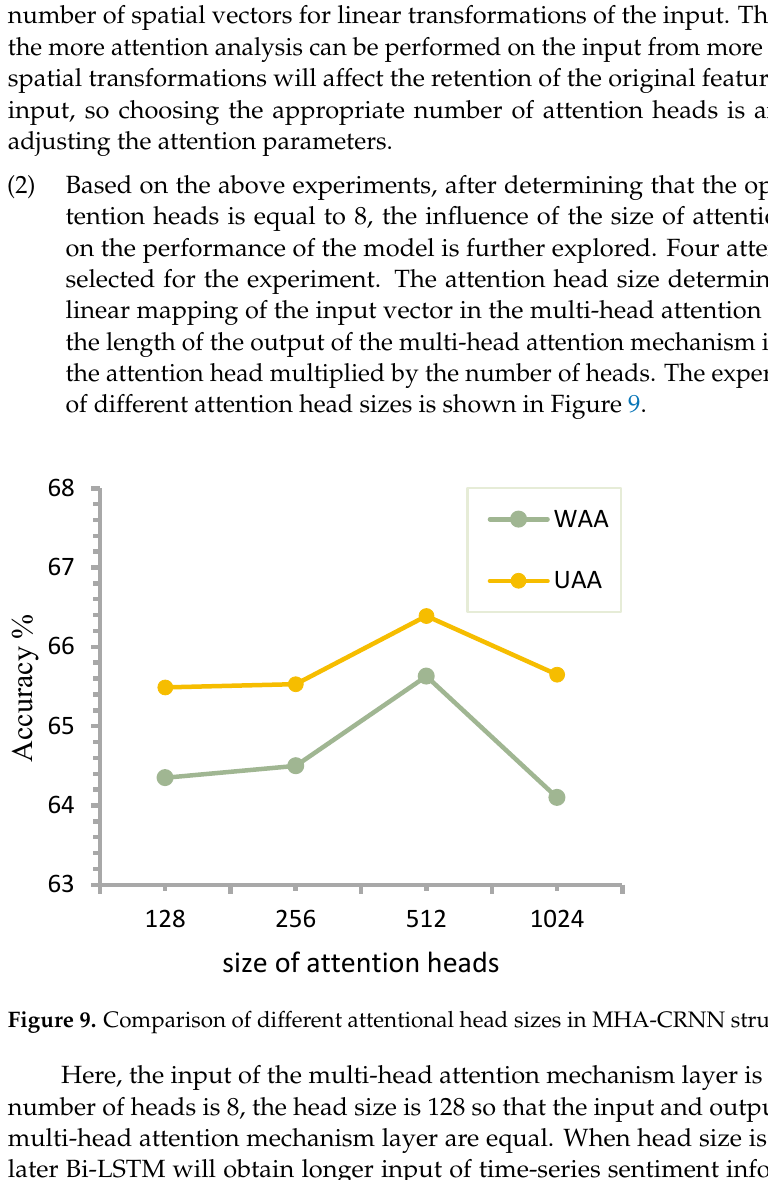
Here, the input of the multi-head attention mechanism layer is [19,1024], When the number of heads is 8, the head size is 128 so that the input and output dimensions of the multi-head attention mechanism layer are equal. When head size is larger than 128, the later Bi-LSTM will obtain longer input of time-series sentiment information. As shown in Figure 9, the classification results obtained when the number of attention heads is 256, 512, and 1024 are all better than the case when the head size is 128. However, the increase of attention head size does not always lead to performance improvement, and either too large or too small will lead to performance variation. This proves that choosing the right attention head size is also an important step in tuning the attention parameters. The size of the attention head reflects the dimensionality of the attention vector obtained by linearly mapping the input vector. A small dimensionality of the mapping may result in the loss